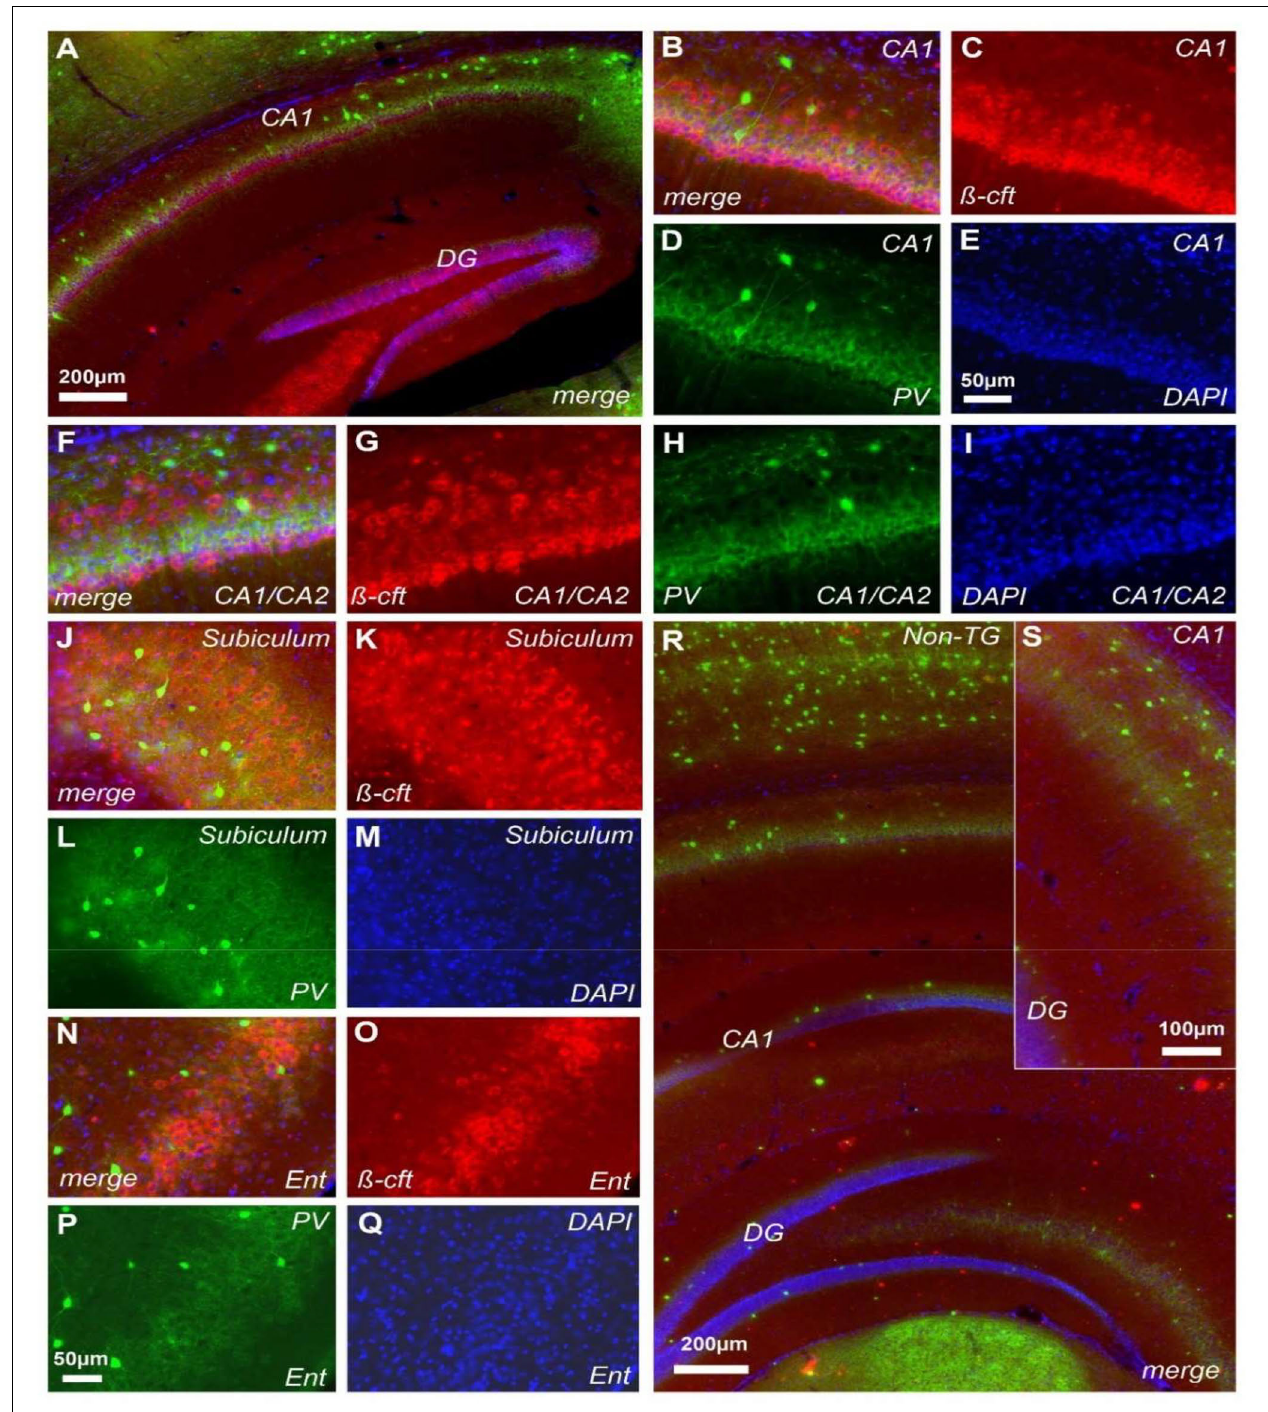
FIGURE 5 | Cerebral b-CTF deposition in J20 mice. Immunohistochemical staining in the hippocampus of J20-TG mice with CT20 (red), PV (green), and DAPI (blue) reveals the presence of b-CTF in CA1 and DG (A) . Further characterization showed that b-CTF is predominantly present in the deeper pyramidal layer along CA1 (B–I) . b-CTF was also found in the subiculum (J–M) and entorhinal cortex (N–Q) . Control mice did not display b-CTF presence in the hippocampal formation (R,S) . See magnification in S7, n = 8, non-TG and 7,